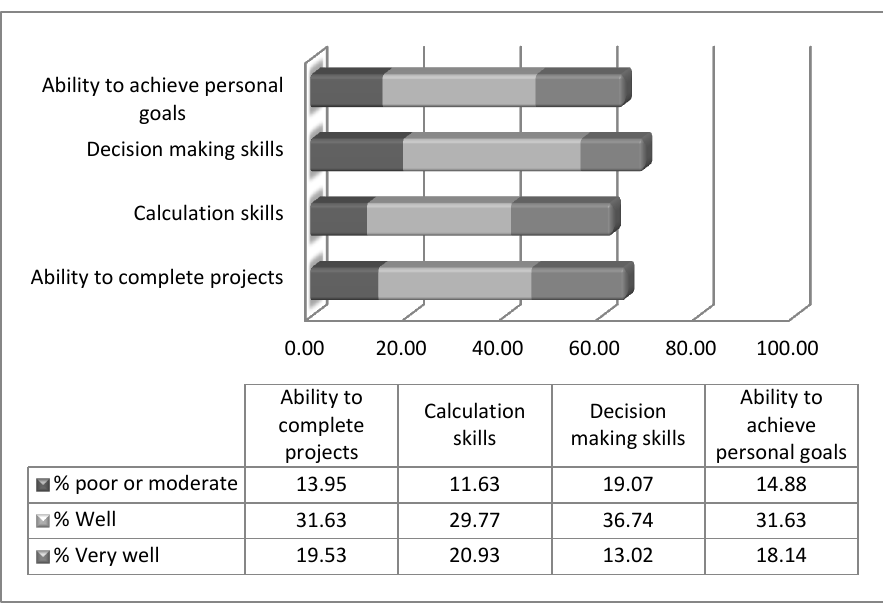
FIGURE 2: Most important skills acquired in the NSC Source: Authors’